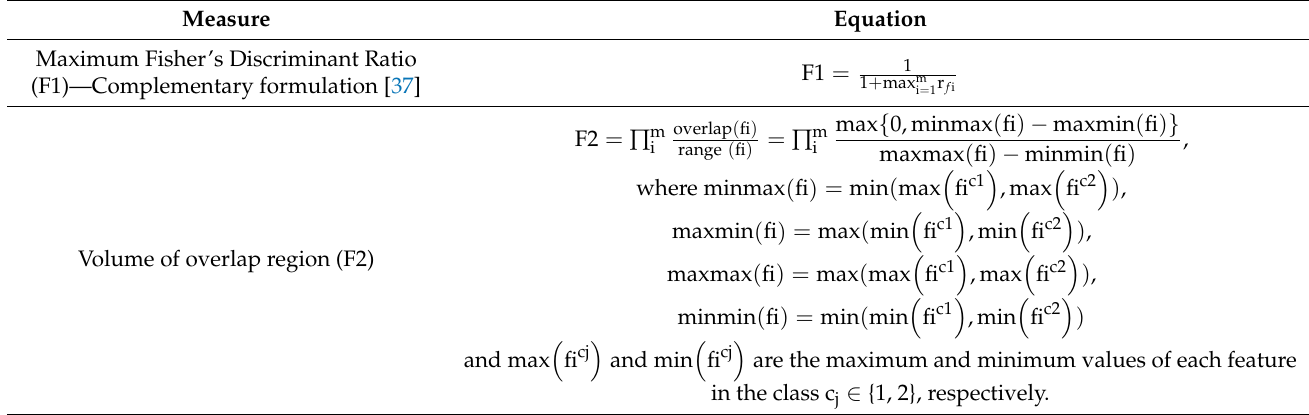
Table 1. Complexity measures